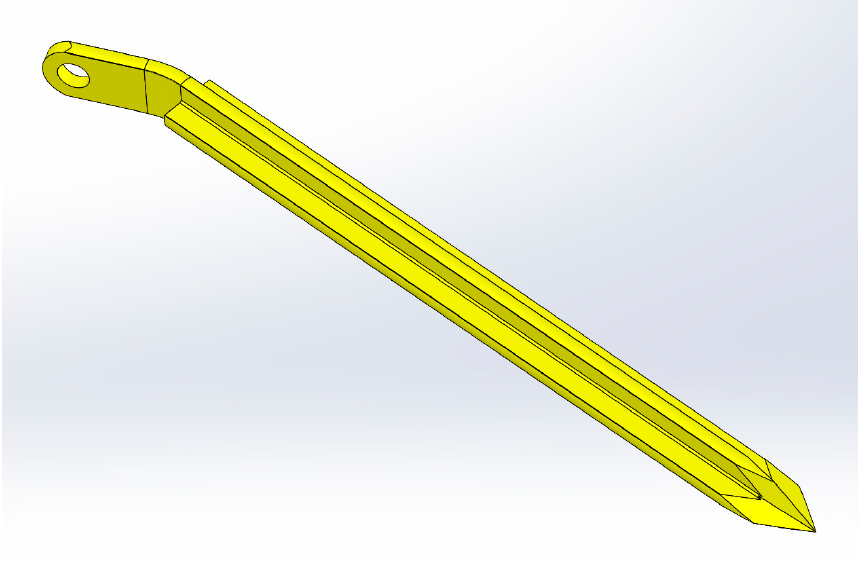
Figure 1. A 3D model of the novel intramedullary splinting implant for superior pubic ramus fracture fixation.